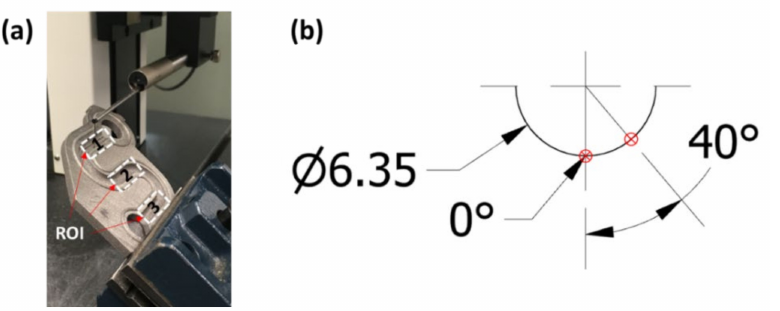
Figure 7. S-shape, Ra measurements (polishing sequence): ( a ) setup and ROIs; ( b ) segment studied.